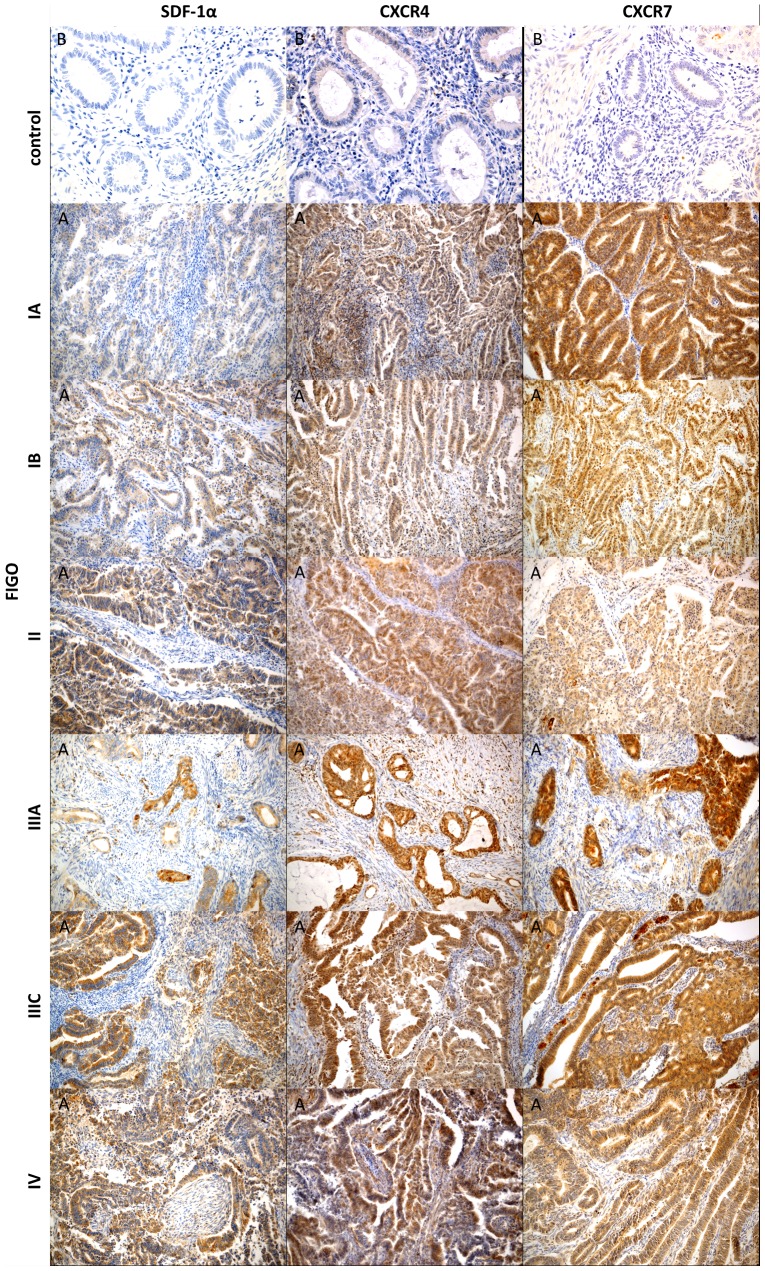
Immunohistochemical representative microphotographs representing the SDF-1, CXCR4 and CXCR7 expression in endometrial cancer according to FIGO classification (IA, IB, II, IIIA, IIIC, IV).(A) Primary objective magnification 10×.(B) Primary objective magnification 20×.